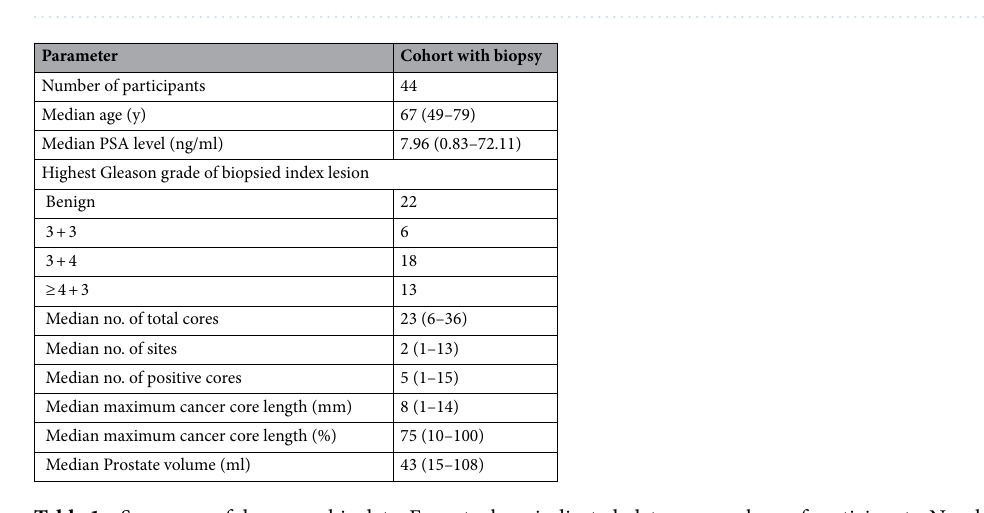
Figure 1. Participation flow diagram. mp-MRI = multiparametric MRI. Among the recruited 44 participants, only five underwent targeted biopsy and were scanned twice for repeatability analysis, while the remaining 39 underwent targeted biopsy only, without scan-rescan.